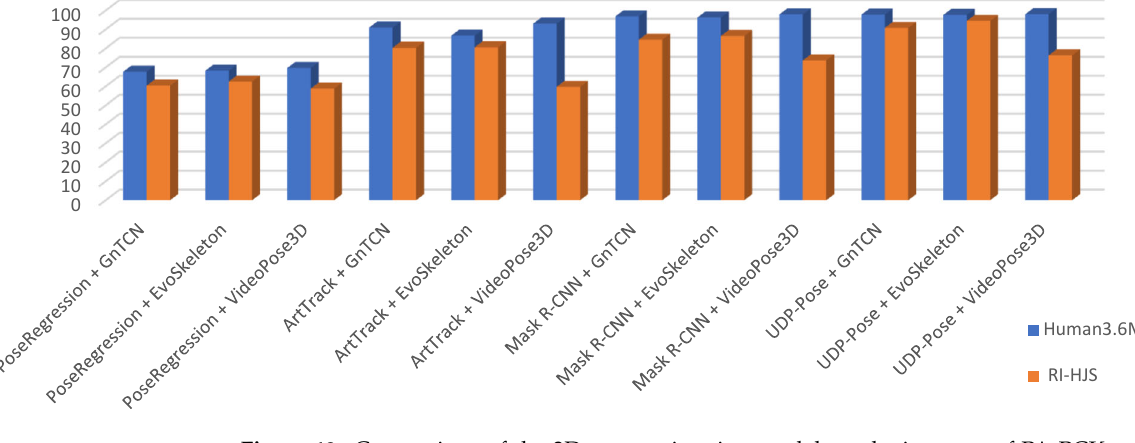
Figure 13. Comparison of the 3D pose estimation model results in terms of PA-PCK on Human 3.6M and custom RI-HJS datasets (higher is better). All models experienced a significant drop in performance on the RI-HJS dataset, except the two-step model UDP-Pose + EvoSkeleton, which retained high accuracy, showing robustness in an unseen environment. It is interesting to note that all two-step models that use VideoPose3D experienced the largest performance drop compared to other models.